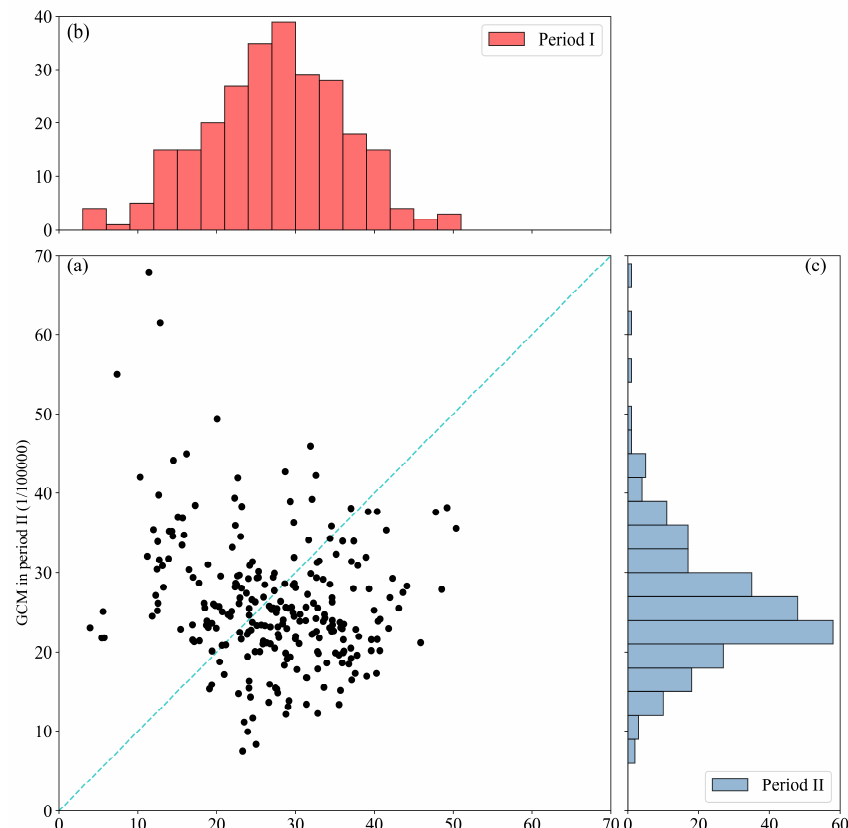
Figure 3. Gastric cancer mortality (GCM) in two periods. ( a ) Scatter plot of GCM; the blue dotted line is the 1:1 line. ( b ) Histogram of GCM in period I, the null hypothesis of normality was retained at the 0.05 level of significance. ( c ) Histogram of GCM in period II, the null hypothesis of normality was rejected at the 0.05 level of significance.